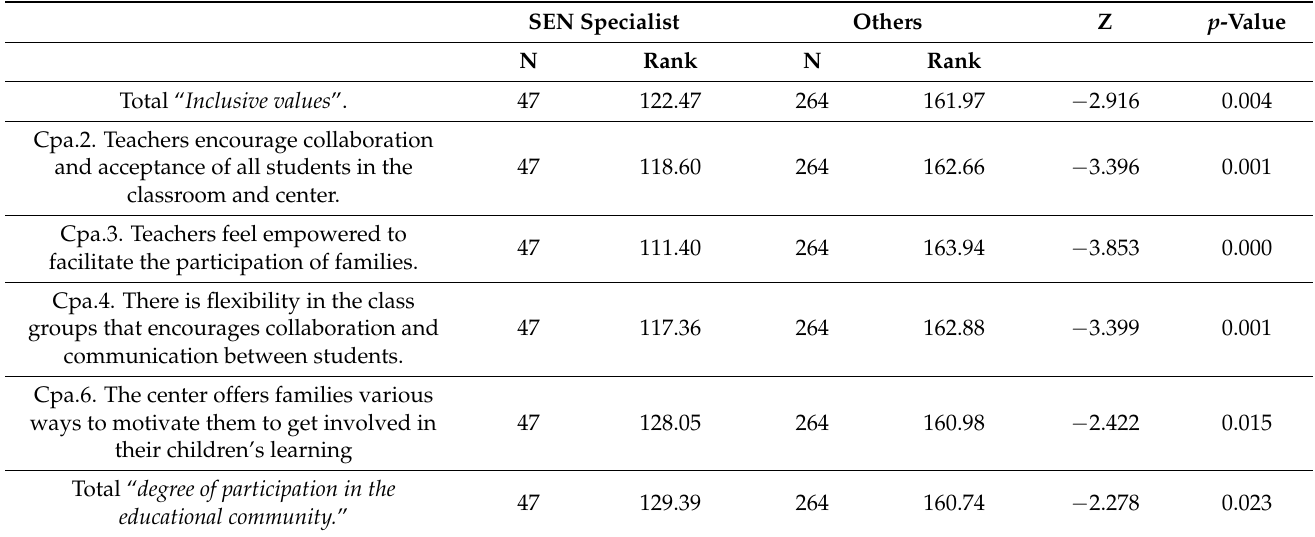
Table 10. Cont. SEN Specialist Others Z p -Value N Rank N